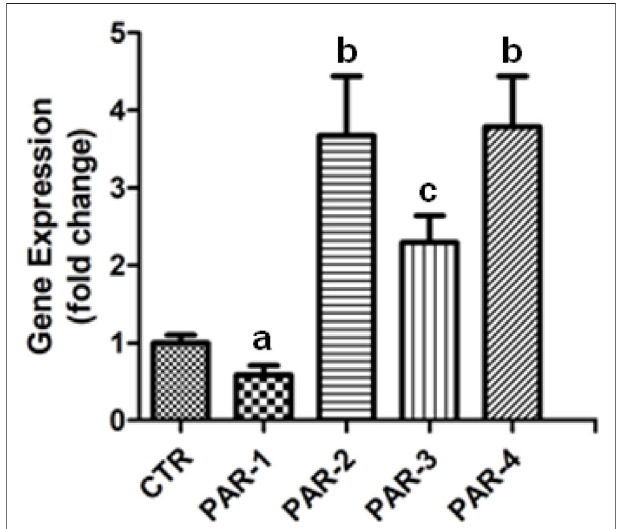
FIGURE 1 | PBM modulate PARs genes expression in DPSCs. Real- time quantitative PCR (qRT-PCR) analysis of gene expression in LPS stimulated DPSCs irradiated with the infrared wavelength (808 nm) with total energy of 6 J (100mW × 60s). The bars represent the mean expression levels of the four PARs genes and standard error. The qRT-PCR analysis of gene expressions was normalized to the housekeeping gene enzyme β -2- microglobulin for DPSCs (control); the relative quanti fi cation of the expression levels (experimental/control) was determined based on the 2- Δ Ct method. Experiments were performed in triplicate. Different letters indicate statistically signi fi cant differences ( p < 0.05 ) in gene expression.